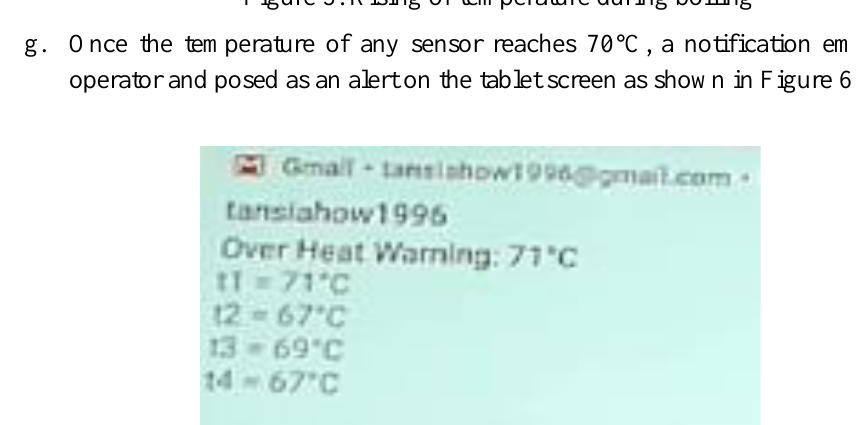
Figure 5. Rising of temperature during boiling